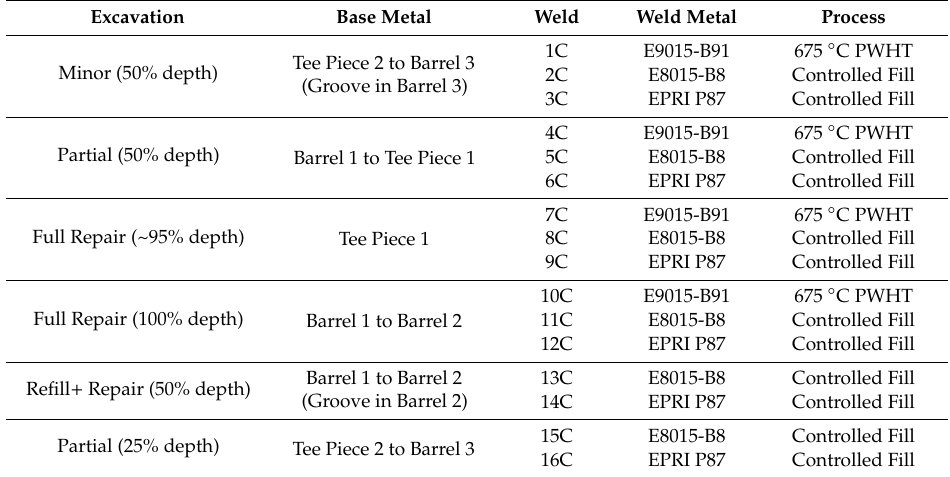
Table 2. Variables Studied in the Examination of Well-Engineered Repair Methods in Grade 91 Steels.